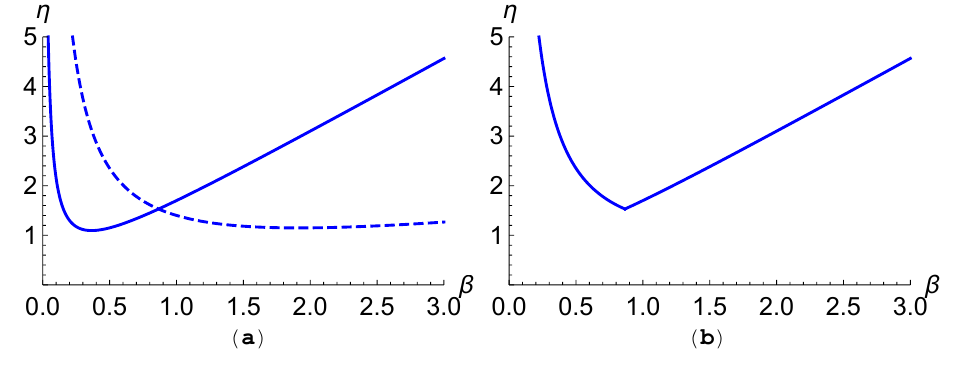
Figure 5. ( a ) Eigenvalues of H β in the case of µ = 0 when D e = 0.3, D d = 1.5, r e = 1.1, r d = 0.2. ( b ) η corresponding to each β for µ =